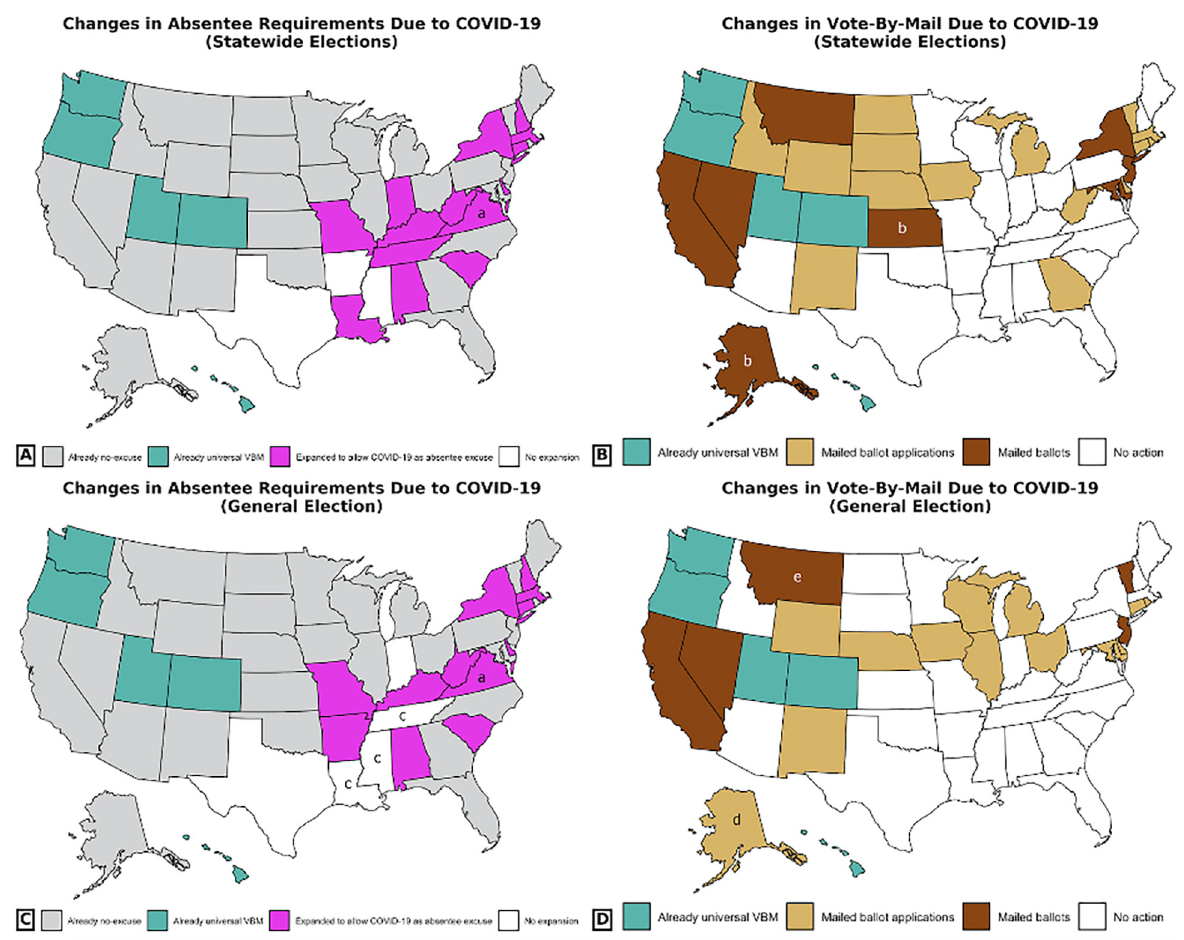
Figure 3. Nationwide map of election process changes due to